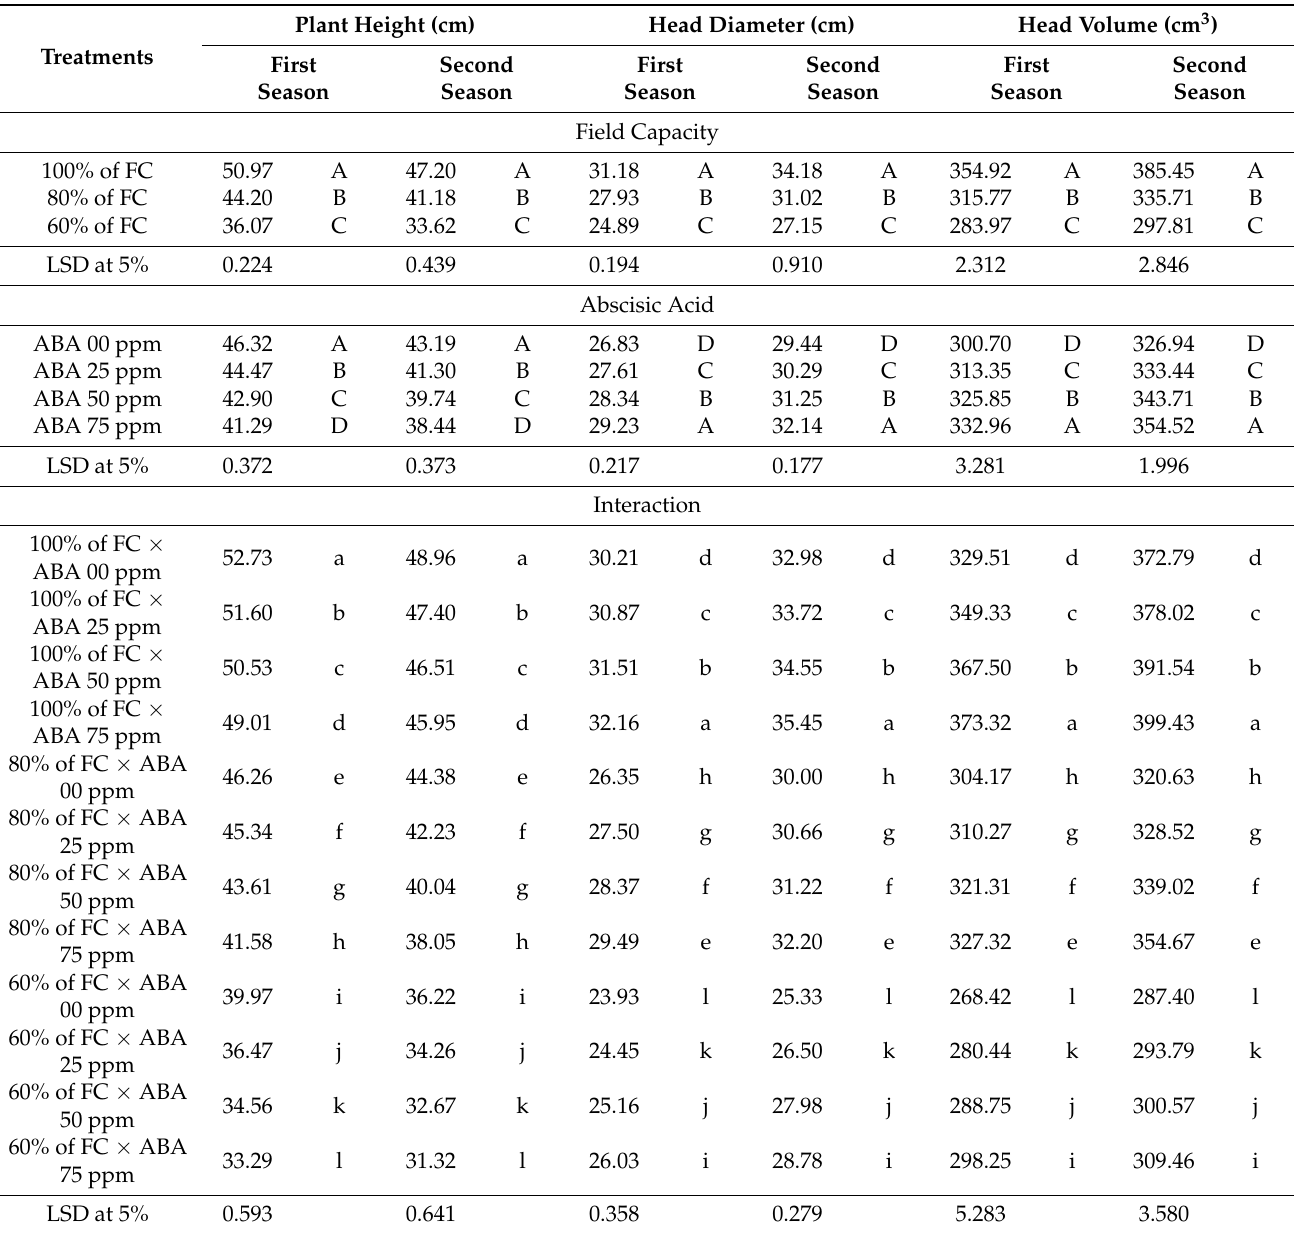
Table 2. Effect of water stress and abscisic acid on plant height, head diameter, and head volume of red cabbage plants (2021–2022